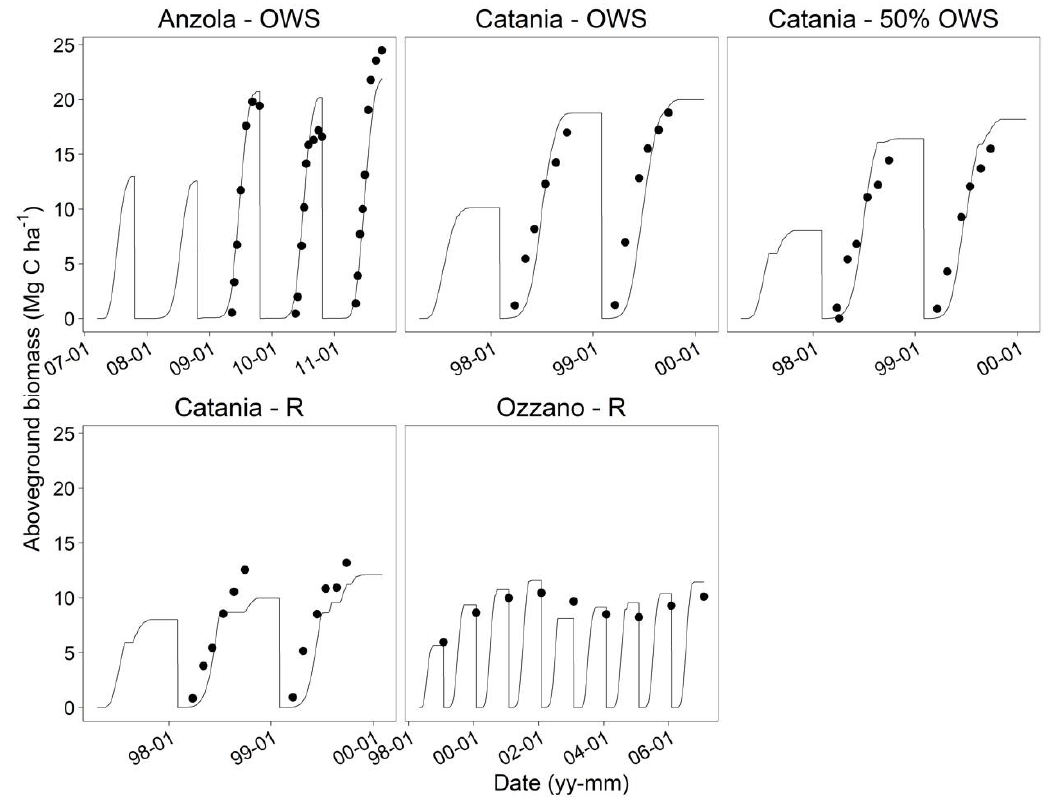
Figure 4. Model performances in reproducing the dynamics of carbon accumulation in aerial biomass (CAAB, black line) during the vegetative season of giant reed. Measurements of CAAB (black dots) were collected in three experimental sites in the 1997–2013 period, from plots with (R = rainfed) and without (OWS = optimum water supply) water stress and with different combinations of stand densities and harvest times. Anzola and Ozzano are located in the province of Bologna (Northern Italy), whereas Catania is situated in the province of the same name (Southern Italy). In BO, abundant precipitation (annual mean of 840 ± 40 mm) and high soil water retention capacity under current conditions are enough to ensure potential conditions for water availability, preventing irrigation treatments during growing seasons. Conversely, in the CT province, a total of about 400 mm of irrigation water was applied during each growing season in order to avoid crop water stress, given the low precipitation and high temperature during the April–September period.